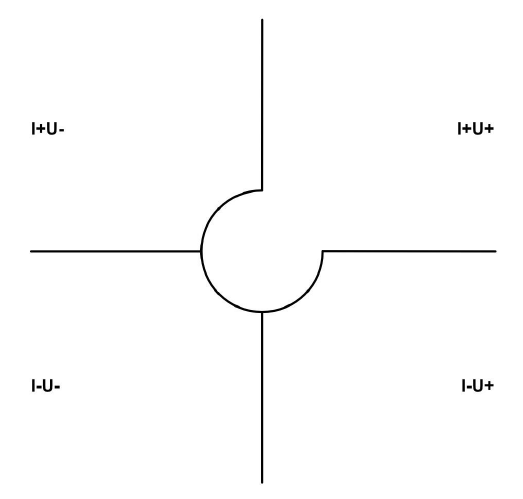
Figure 3: Modified OK